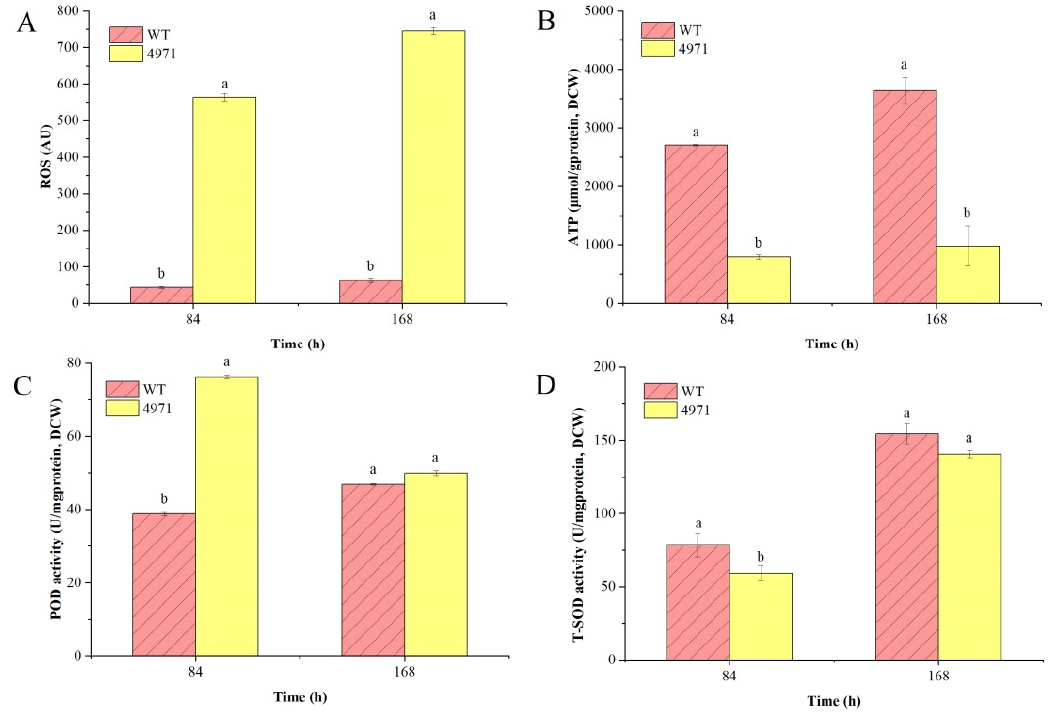
Figure 8. Comparison of intracellular ROS level ( A ), ATP concentration ( B ), and the enzyme activities of peroxidase ( C ) and superoxide dismutase ( D ) of the parent strain and mutant strain during submerged batch-fermentation. Different letters (a and b) in the same column indicate a significant difference ( p <